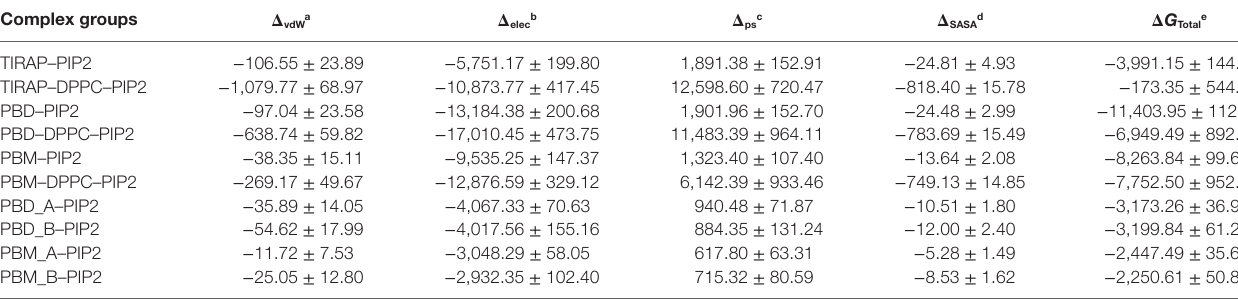
TaBle 2 | Binding free energy (kJ mol − 1 ) between PIP2 and important segments of TIRAP. complex groups